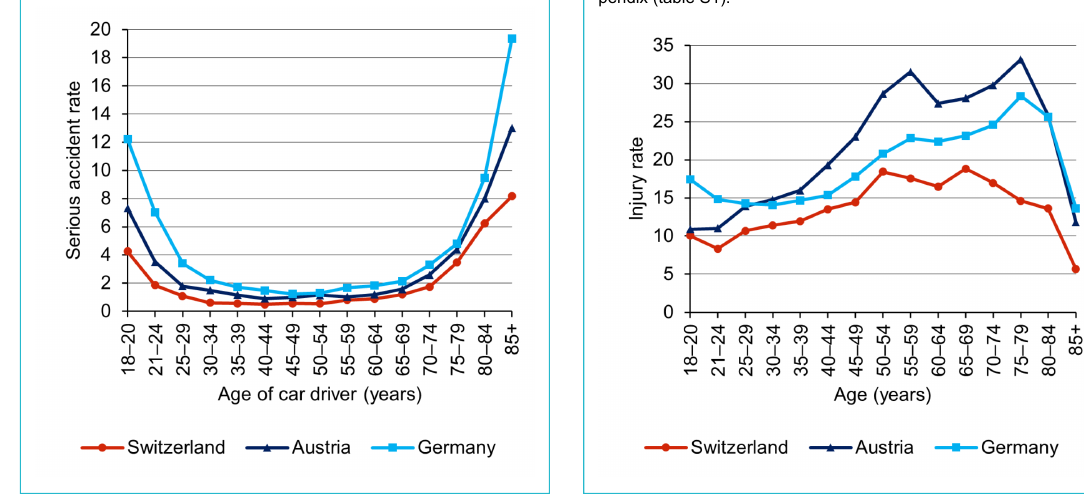
Figure 5: Seriously or fatally injured (e-)cyclists per 100,000 in- habitants, by age group and country. The corresponding numerical values including 95% confidence intervals can be found in the ap- pendix (table